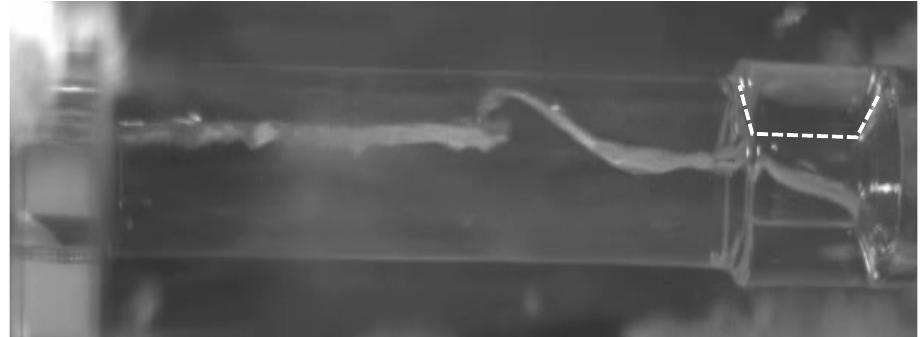
Figure 12. Stratified wavy flow upstream of the orifice.